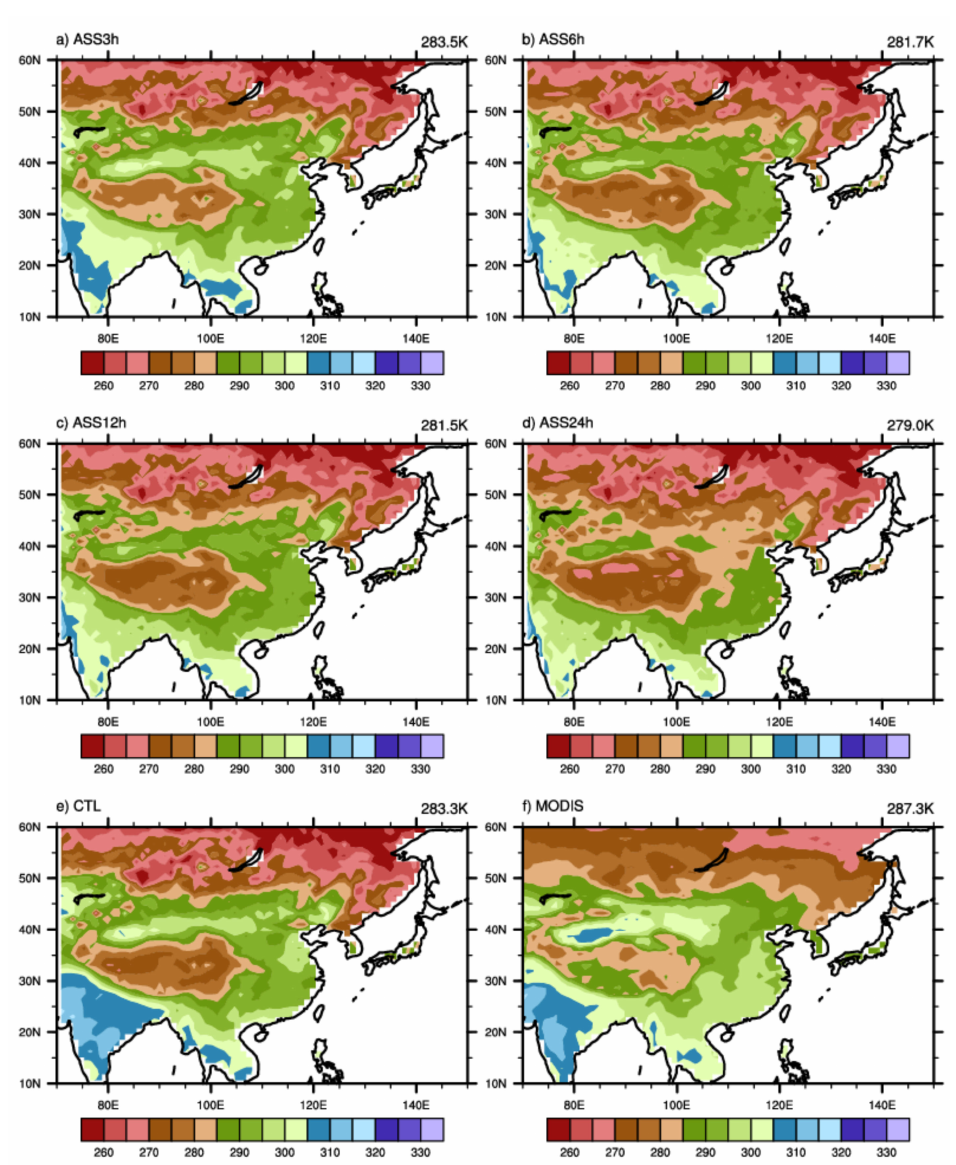
Figure 2. The spatial distributions of the daytime annual mean LST (K) for the assimilation exper- iments with ( a ) 3 h, ( b ) 6 h, ( c ) 12 h, ( d ) 24 h time frequencies, ( e ) the CTL experiment, and ( f ) the MODIS